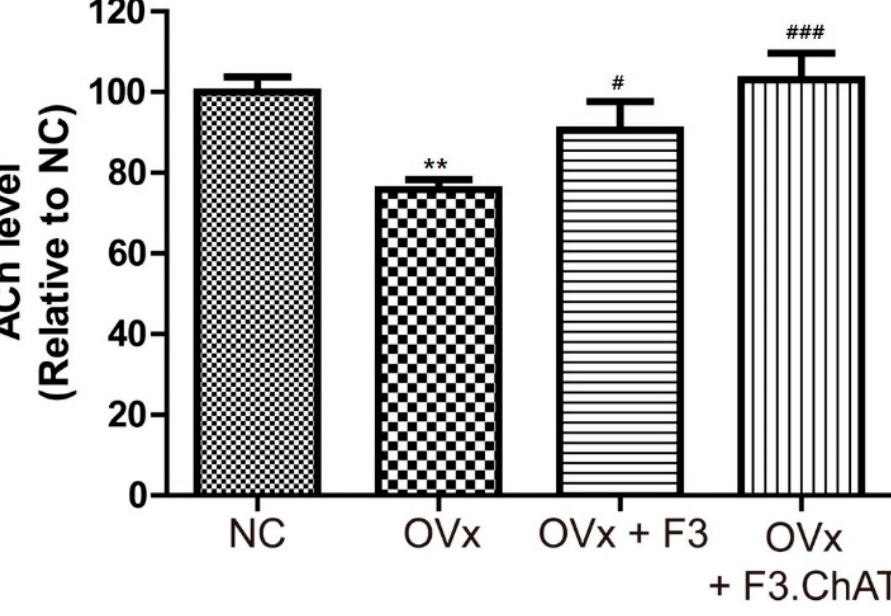
Figure 7. Acetylcholine (ACh) level in the CSF of ovariectomized rat four weeks after transplantation with F3 or F3.ChAT cells. ACh levels were analyzed using an ELISA kit. ** Significantly different from the normal control ( p < 0.005). # Significantly different from the OVx ( p < 0.05) group. ### Significantly different from the OVx ( p < 0.05) group.